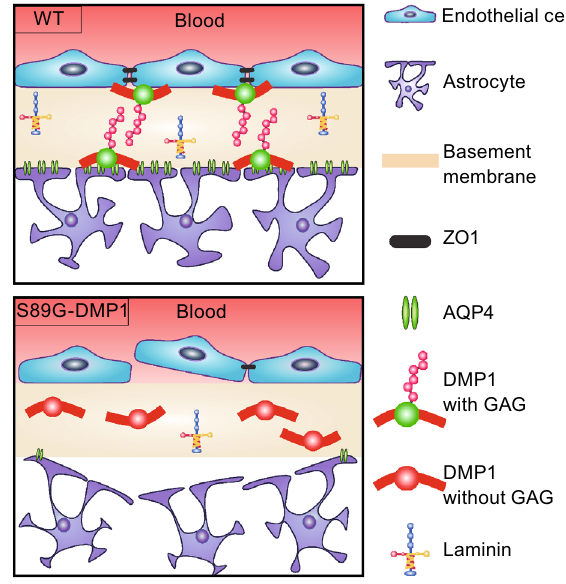
Figure 5. Proposed model of how deglycosylation of DMP1 affects astrocyte maturation and BBB integrity. Under physiological conditions, showed in WT, astrocytes could accurately target to brain blood vessels, wrap around vessels, and seal the cell gaps between endothelial cells through cell-cell interaction. When the GAG chain of DMP1 is lost during pathological state, astrocytes shrink, and signi fi ed by the reduction of AQP4 and laminin. As a result, astrocytes have attenuated their propensity of targeting to vessels, and fail to accomplish the sealing function, leading to BBB